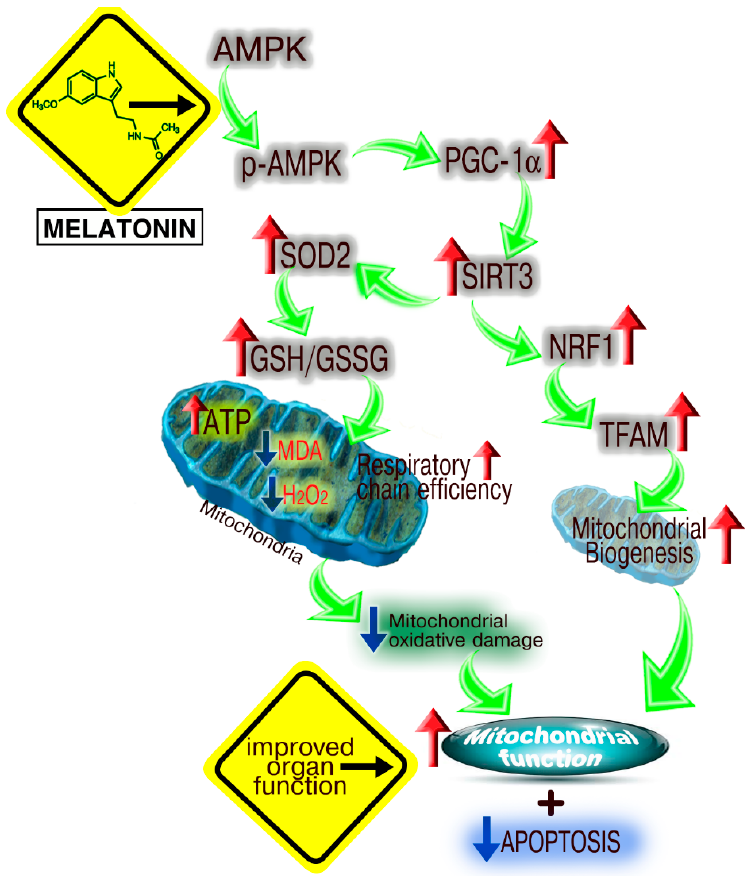
Figure 8. A summary of the proposed mechanisms by which melatonin preserves myocardial cell function after ischemia/reperfusion injury in type 1 diabetic rats. The involvement of AMPK → pAMPK was shown using compound C, a specific blocker of AMPK-signaling. The role of SIRT3 was documented with the use of SIRT3 siRNA. Melatonin protects against myocardial damage due to ischemia/reperfusion as indicated. Figure drawn from the findings of Yu et al. [216]. Red arrows indicate stimulation; blue arrows indicate inhibition; green arrows indicate flow of information.